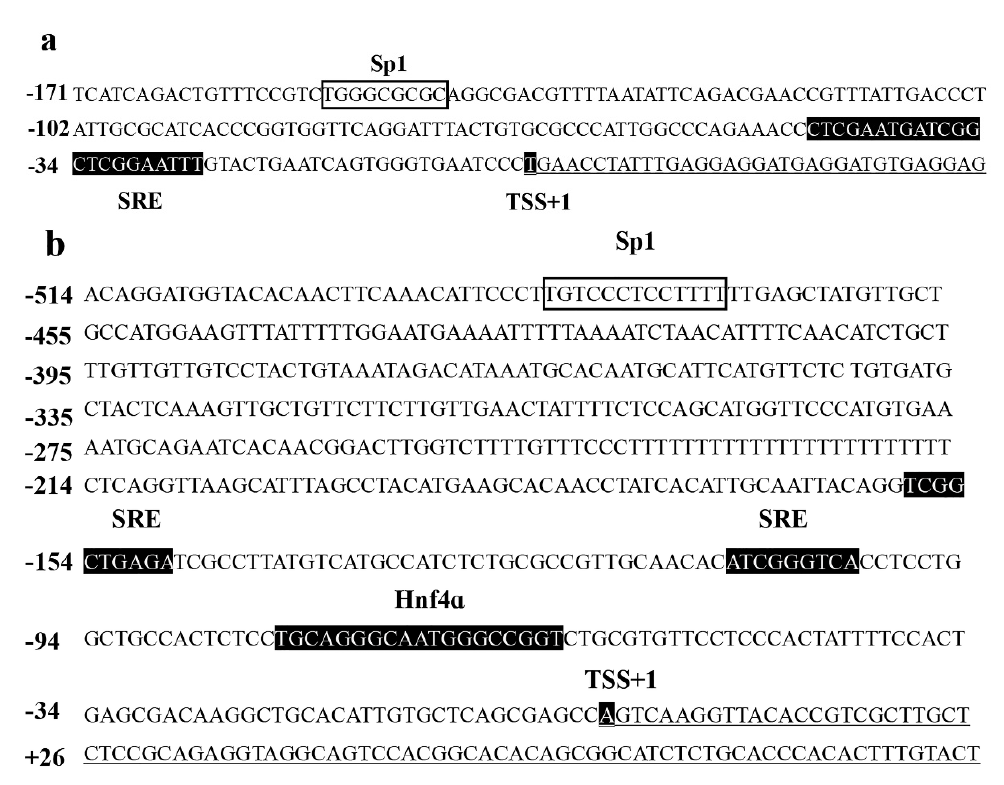
Table 1. Sp1 binding sites predicted in the promoter of rabbitfish S. canaliculatus Δ 6/ Δ 5 fads2 and elovl5 using online software and site-directed mutation sites. Gene Position Predicted Element Mutation Site Δ 6/ Δ 5 fads2 − 159 ~ − 137 TGGGCGCGC GG → TT elovl5